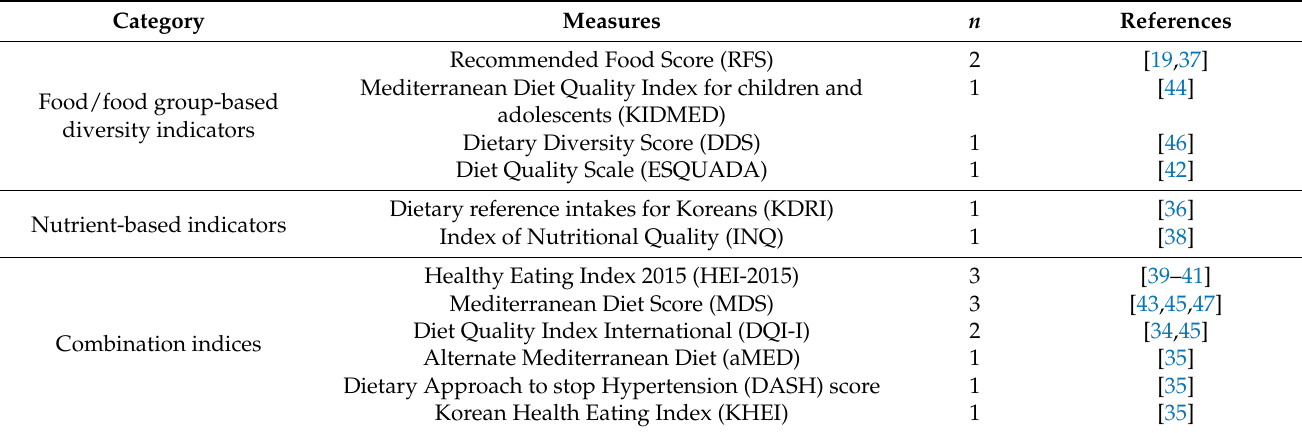
Table 2. Diet quality measures reported in the included studies ( n =